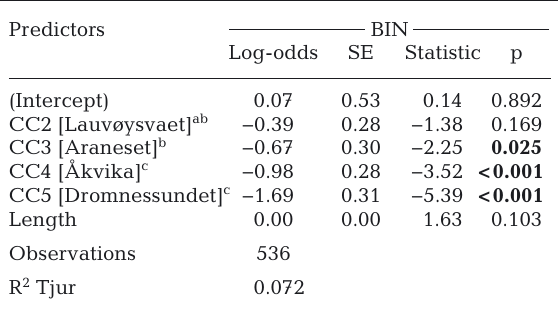
Table 5) and only explained 5% of the variation.